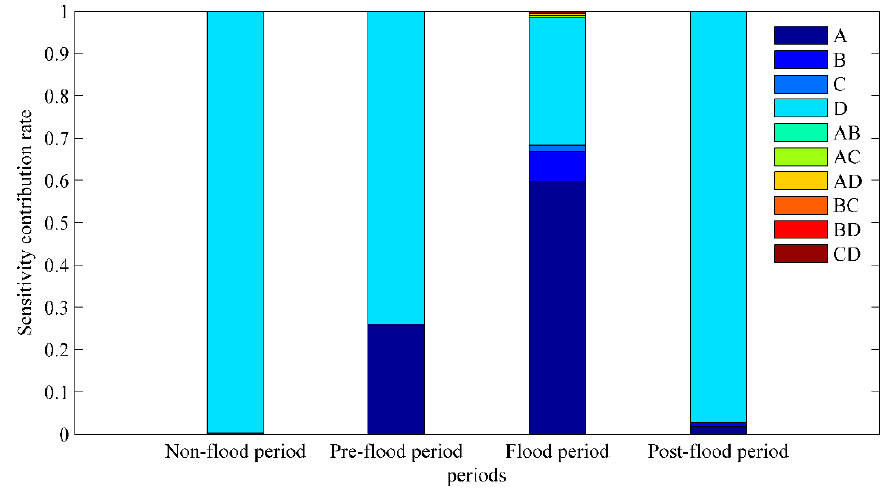
Figure 14. Contribution of individual and interaction parameters to the runoff simulation in different periods.